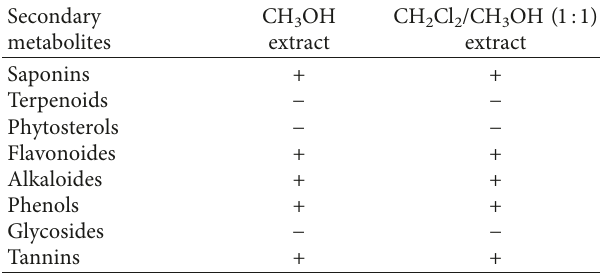
Table 1: Phytochemical screening test